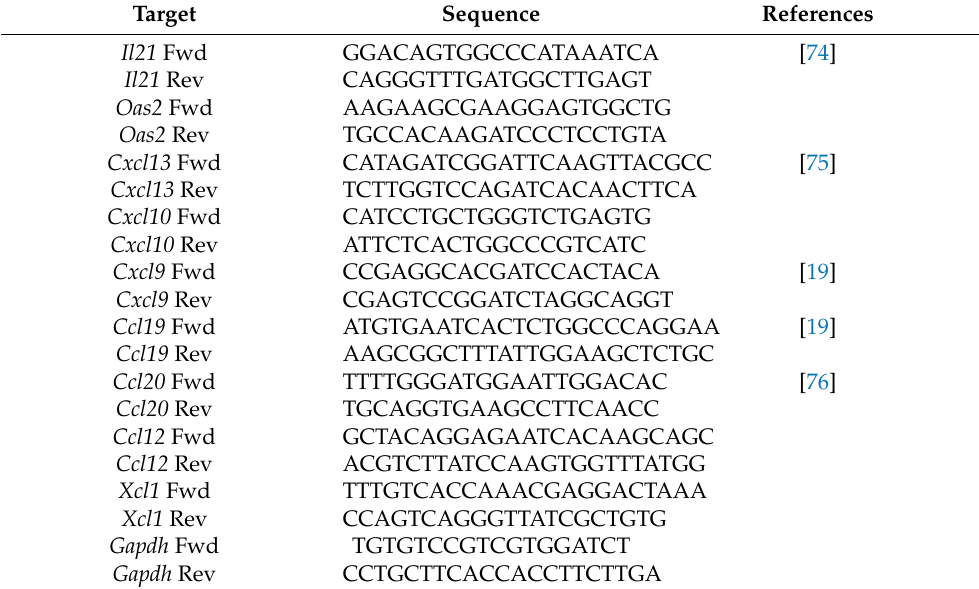
Table 6. Primer sequences for qPCR